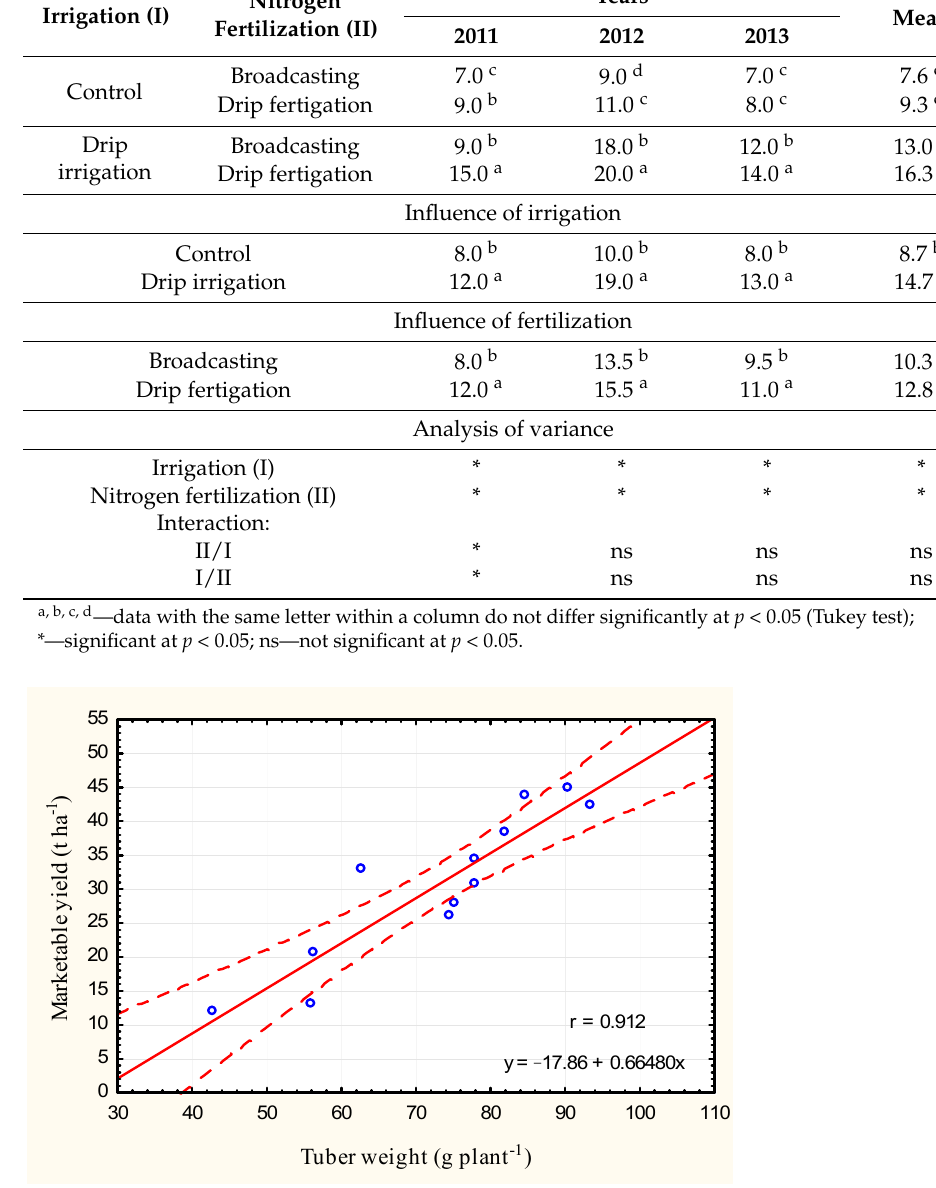
Figure 5. Relationship between marketable yield of tubers and tuber weight per plant of potato cultivar Courage grown under drip irrigation and nitrogen fertilization.